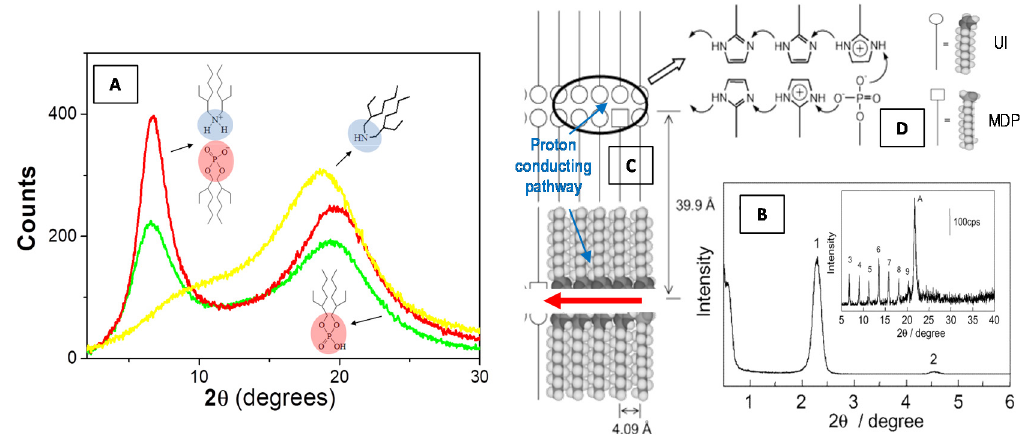
Figure 6. Scattering profile of a bis(2-ethylhexyl)amine/bis(2-ethylhexyl)phosphoric acid binary liquid mixture (equimolar mixture, red line) as compared to the two neat components bis(2-ethylhexyl)amine (yellow line) and bis(2-ethylhexyl)phosphoric acid (green line) ( A ). It can be noted that the mixture shows an increase of the intensity at the low-angle peak as a consequence of the local intermolecular self-assembly ( A ). X-ray diffraction pattern (peak 1) at low angle ( B ) and associated higher-order diffraction peaks at high angle (inset of B ) regions of the 2-undecylimidzole (UI) − monododecyl phosphate (MDP) composite materials, evidence the formation of highly ordered bilayer lamellar structures [85]. The formation of a proton-conduction mechanism ( C ) is favorite by the imidazole headgroups ( D ) that are protonated by the proton transfer from neighboring MDP molecules. Adapted with permission from [85], Copyright 2019 American Chemical Society.